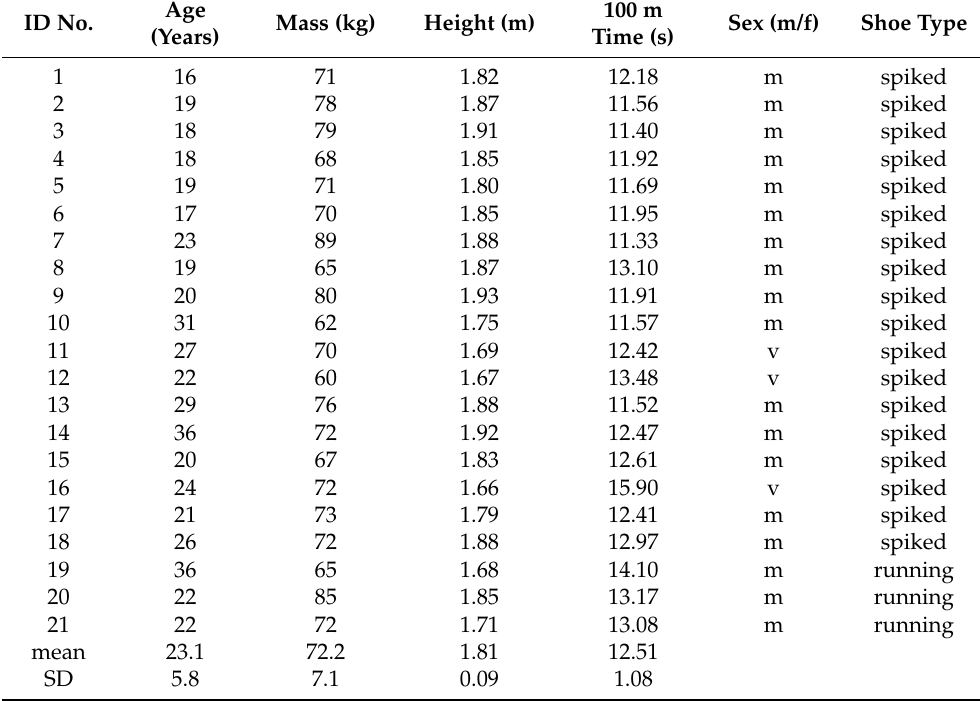
Table 1. Participants’